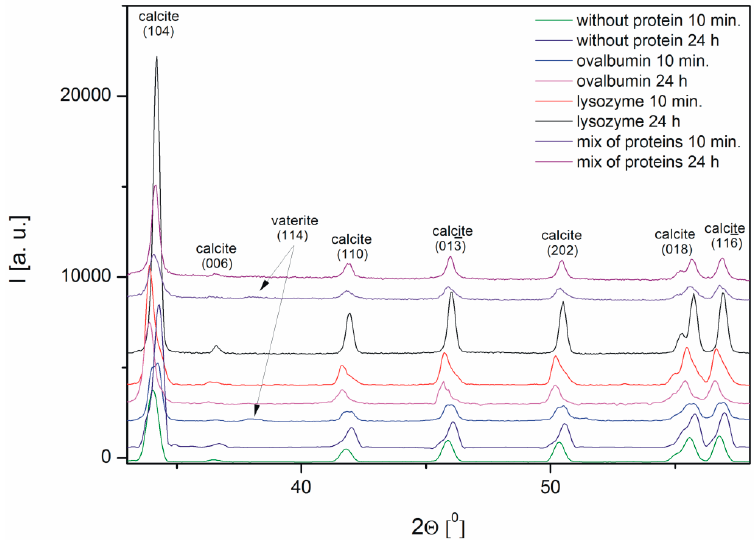
Figure 5. XRD diffraction patterns of the crystal structure of the calcium carbonates precipitated in the absence and in the presence of proteins (0.1%).